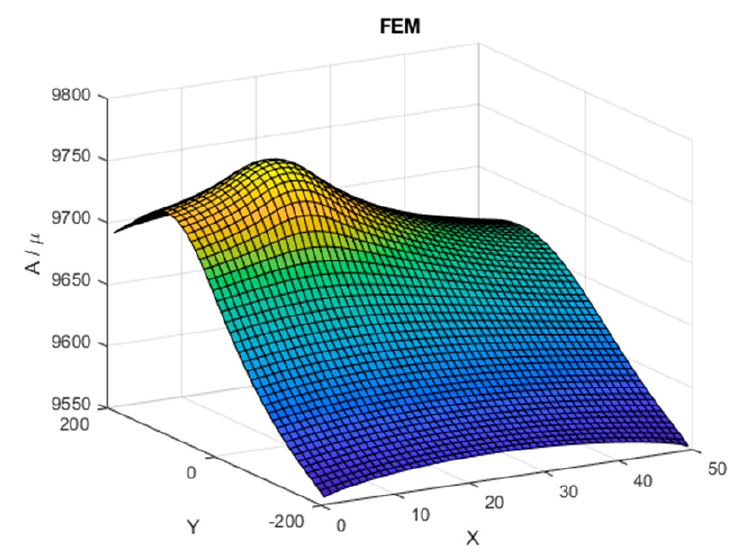
Figure 5. Magnetic potential A ( x , y ) / µ 0 in the air window was obtained from the finite element method. Figure 6 presents the components of the magnetic field H x ( x , y ) and H y ( x , y ) along boundaries of the air window,